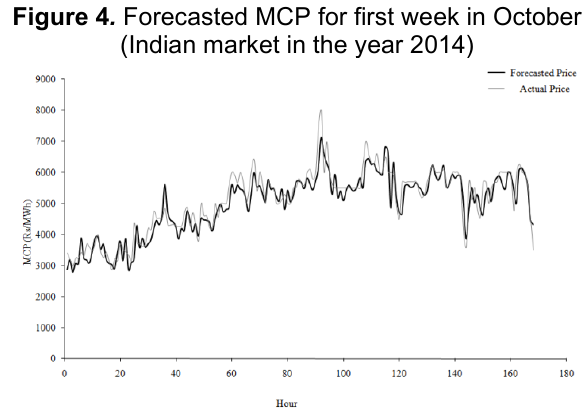
Figure 4 . Forecasted MCP for first week in October